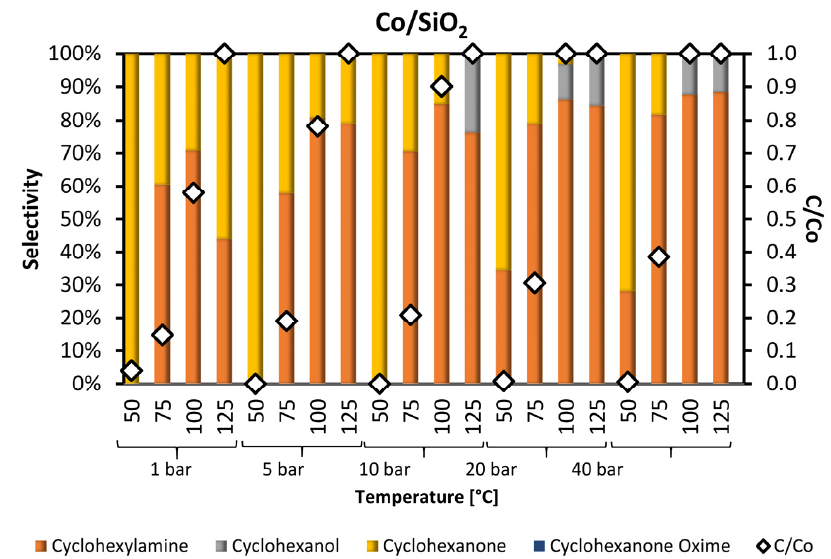
Figure 8. Catalytic hydrogenation of nitrocyclohexane in liquid flow conditions with Co/SiO 2 .